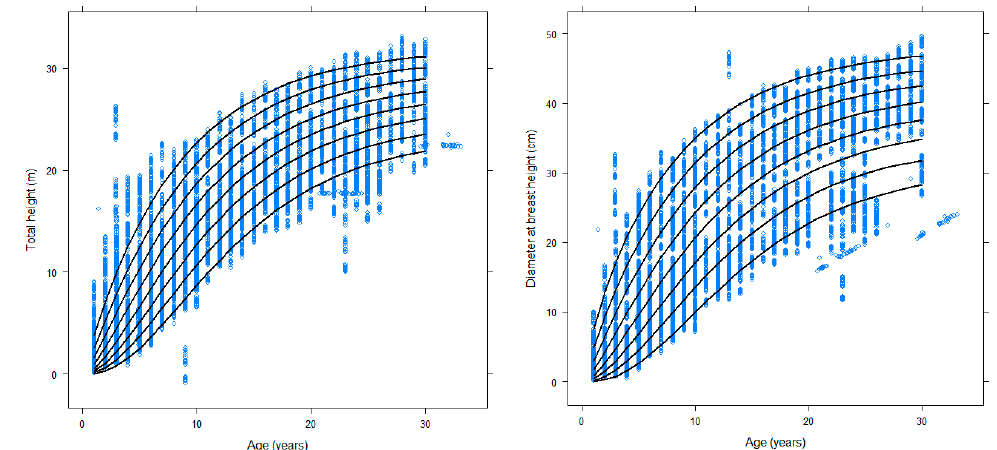
Figure 4. Curves fitted with the GADA model for the relationship between age and mean dominant total height and mean dominant diameter at breast height during development of growth models for Tectona grandis in living fences in coastal lowlands of Ecuador.